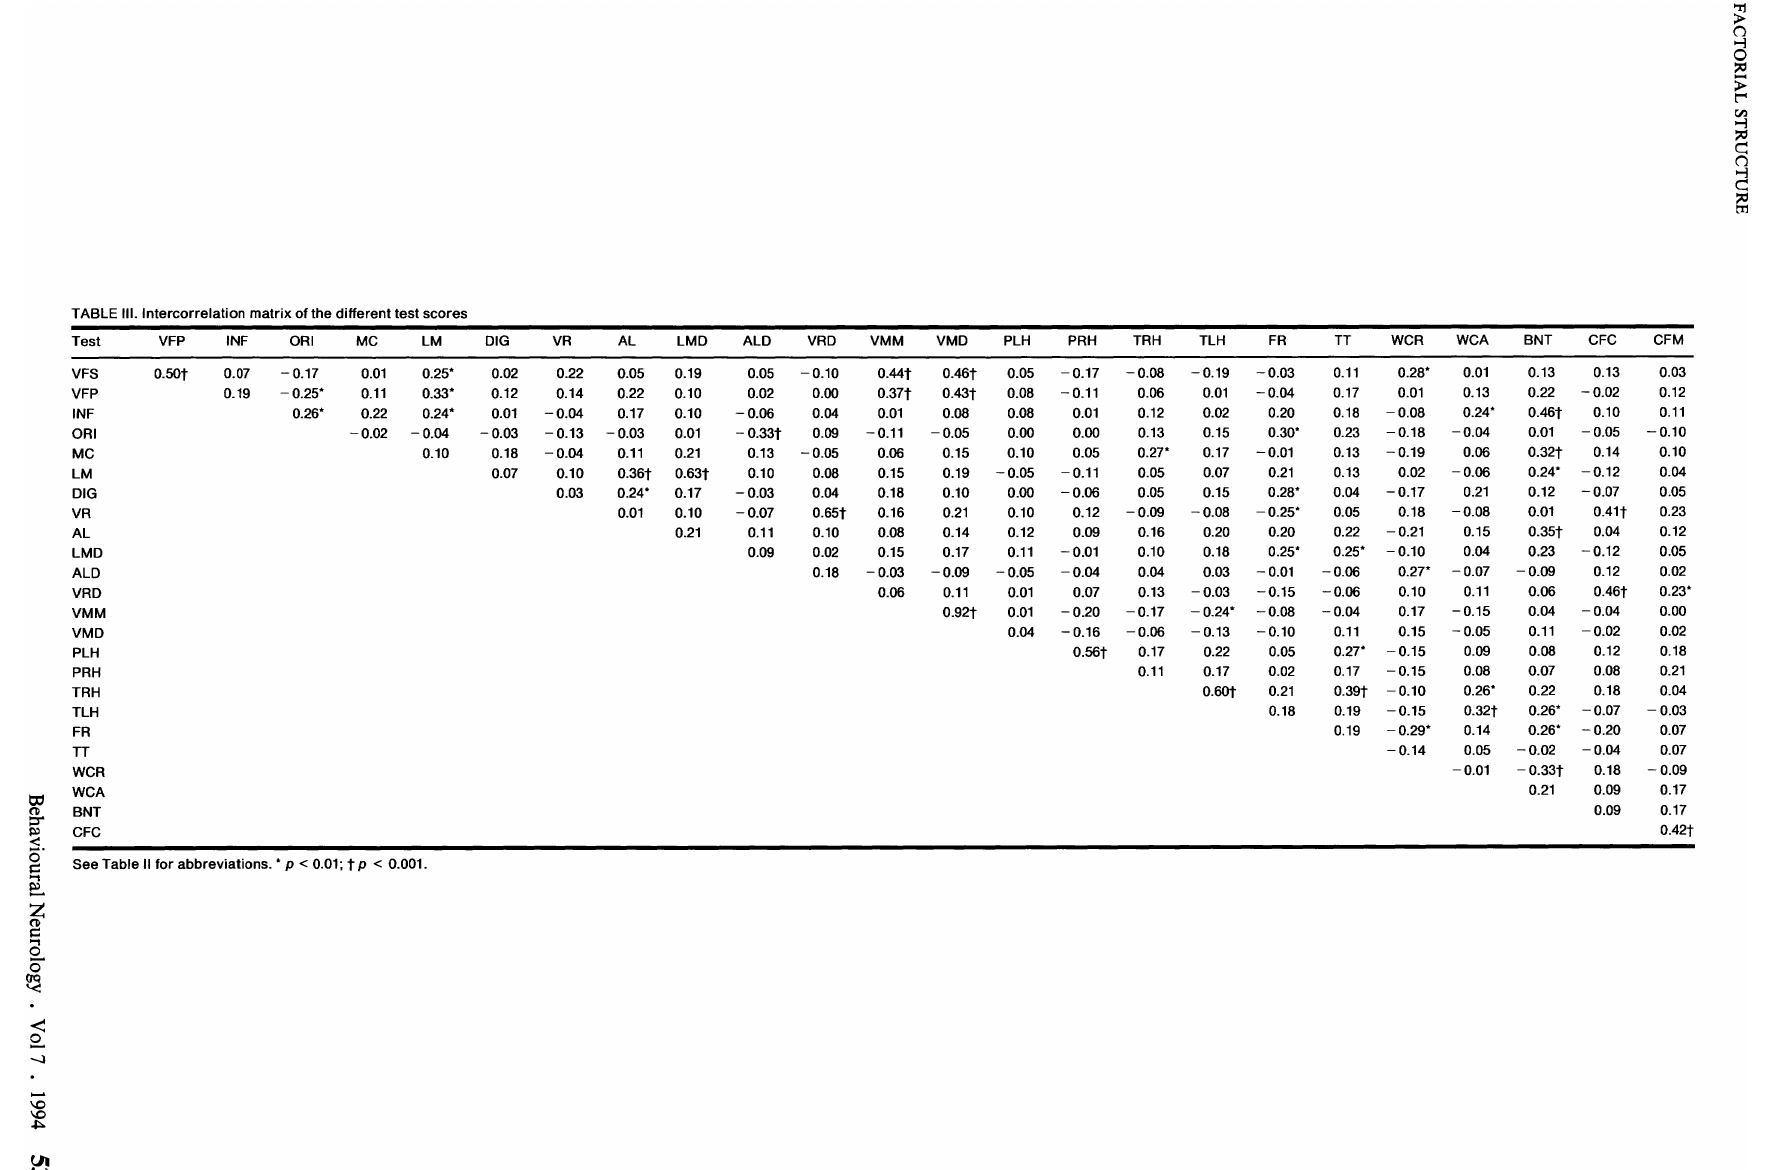
TABLE III. Intercorrelation matrix of the different test scores Test VFS VFP INF